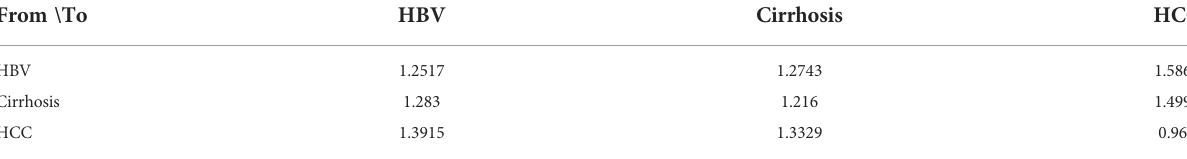
TABLE 2 Distance from to. From \To